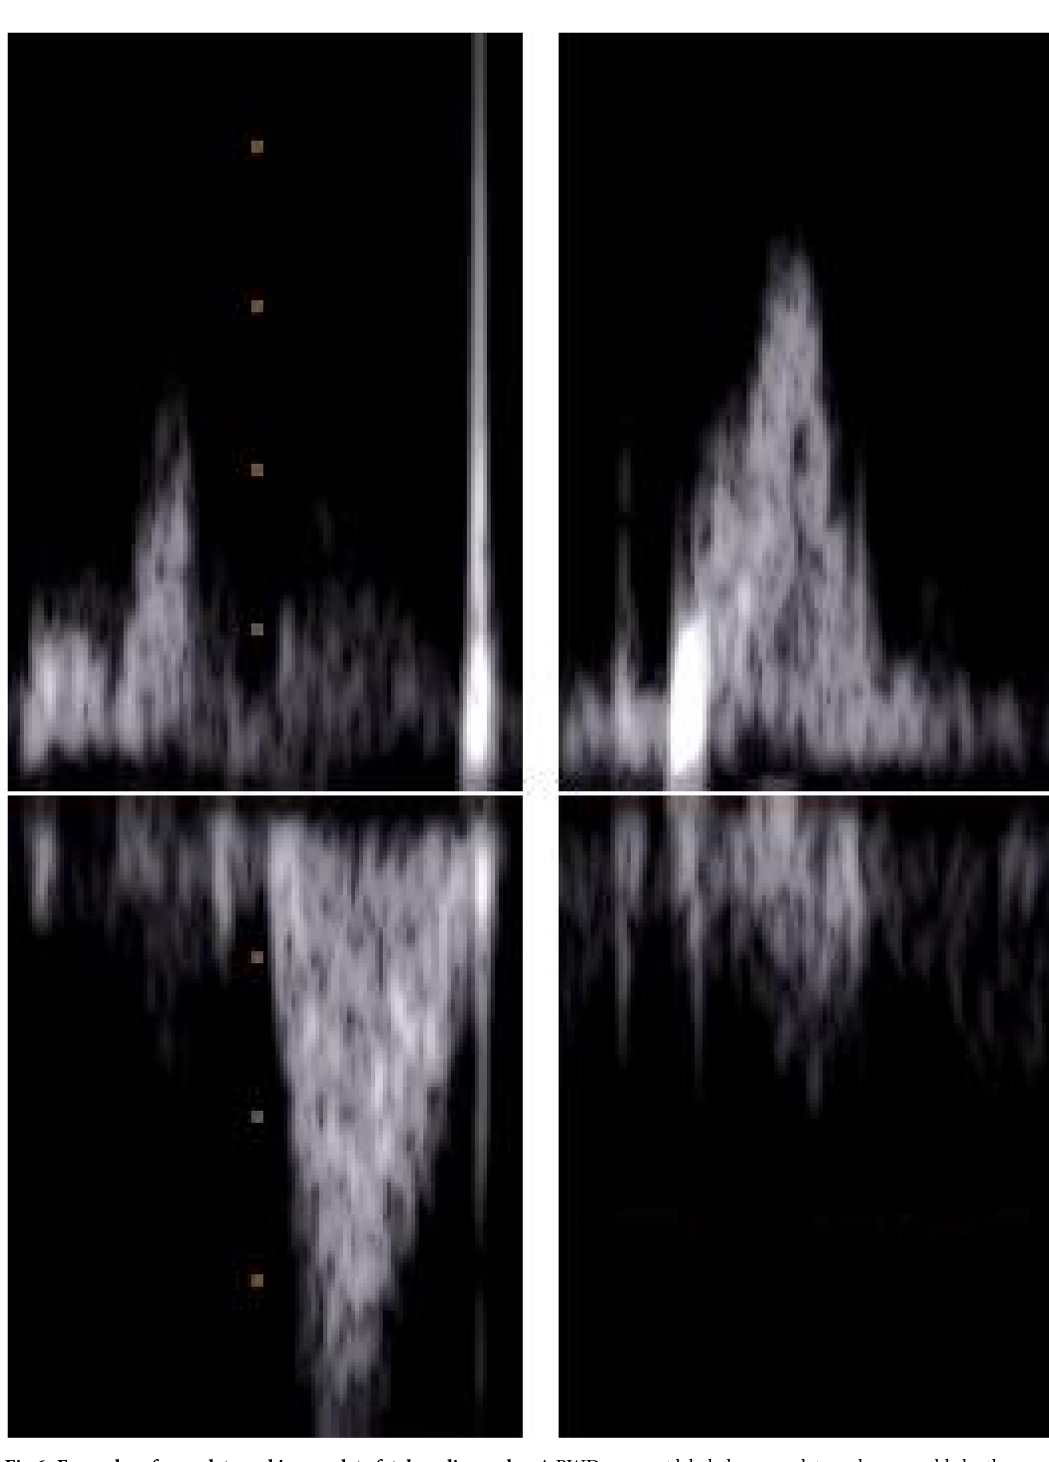
Fig 6. Examples of complete and incomplete fetal cardiac cycles. A PWD segment labeled as complete and measurable by the cardiologist, with clear E/A and V patterns (left), and a PWD segment labeled as incomplete/malformed (right).